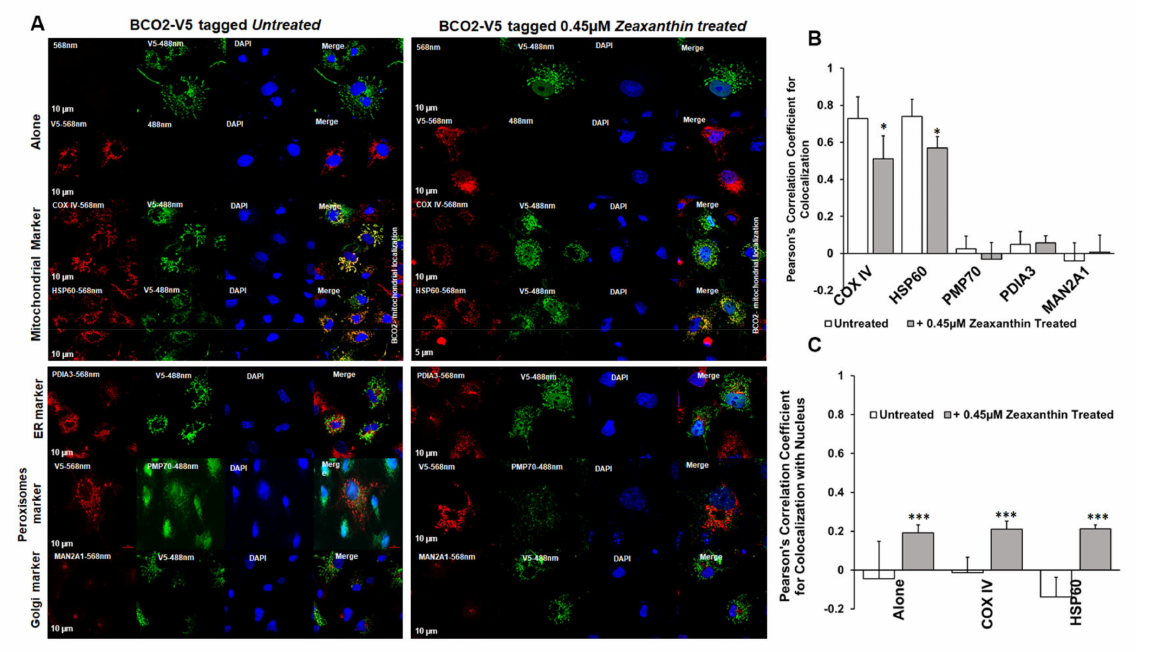
Figure 4. Characterization of subcellular localization of mBCO2 treated with zeaxanthin. ( A ) COS7 cells expressing V5- tagged mouse BCO2 protein treated with 0.45 µ M zeaxanthin for 5 h were immunoassayed using antibodies against V5 tag and different organelle marker proteins as indicated in the Materials and Methods section. Pearson’s correlation coefficient s were calculated for colocalization of V5-tagged mBCO2 protein with different organellar marker proteins ( B ) and with nucleus ( C ); * p ≤ 0.05; *** p ≤